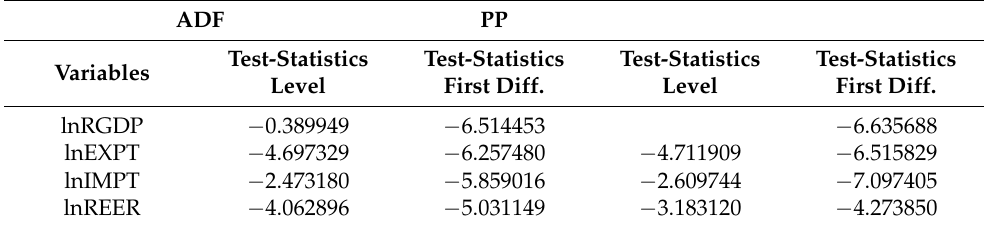
Table 2. ADF and PP Stationarity